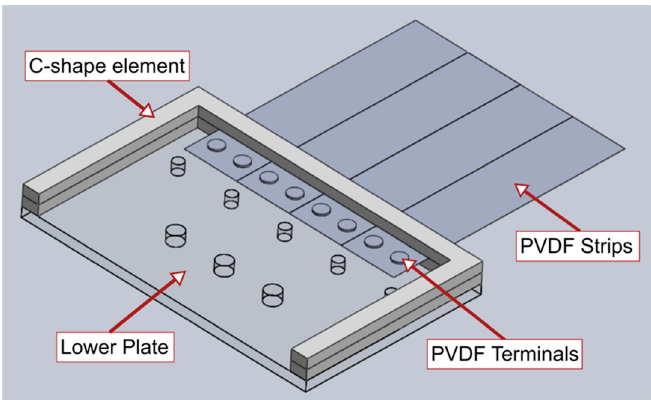
Figure A1. Computer-aided design (CAD) drawing of the support clamp (the upper plate was removed for clarity).